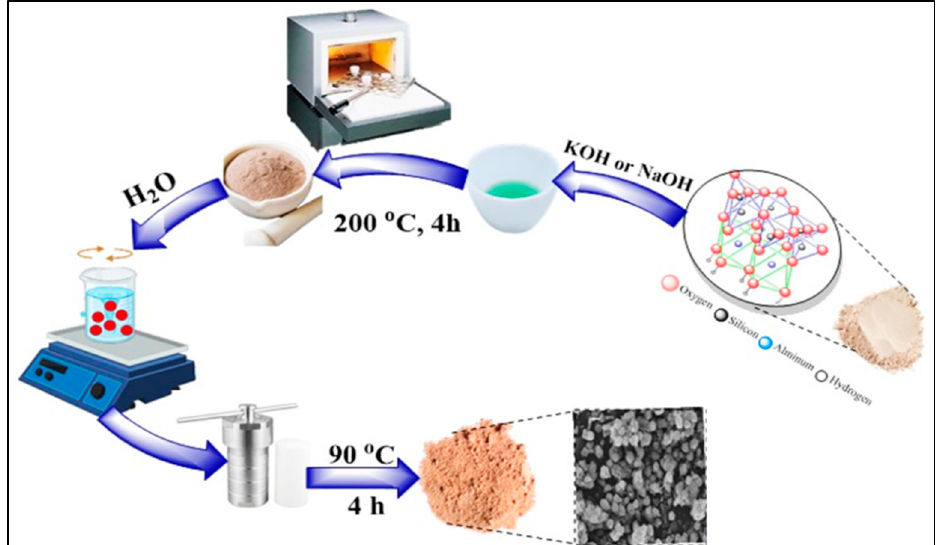
Figure 6. Schematic diagram of the synthesis procedures of Na.sodalite and K.sodalite.